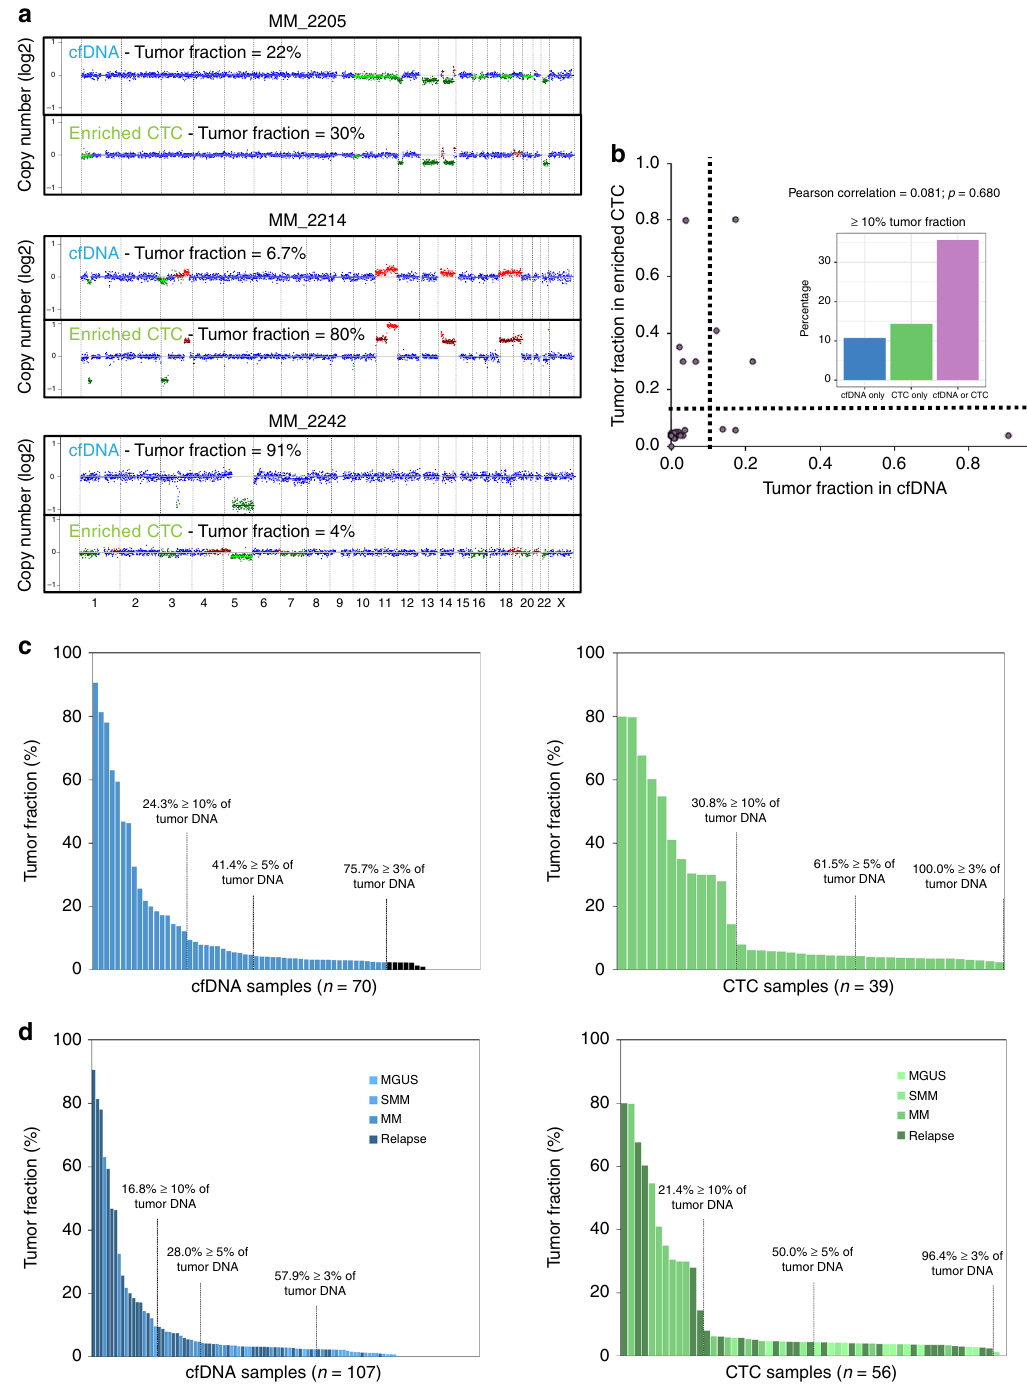
Fig. 1 Detectability of CTCs and cfDNA in multiple myeloma. a Comparison of copy ratios between cfDNA ULP-WGS and CTC ULP-WGS from same MM patients. Ampli fi cation (red), deletion (green), and copy neutral (blue) are indicated. b Comparison of tumor fraction of matched cfDNA and CTC samples as determined via ULP-WGS and ichorCNA. Dashed line indicates 10% tumor fraction. Percentage of patients with ≥ 10% tumor fraction for cfDNA only (blue), CTC only (green), and cfDNA or CTC (purple) is indicated. Pearson correlation coef fi cient was calculated between the tumor fraction in cfDNA and CTC (Pearson correlation = 0.081; p -value = 0.680). c ULP-WGS tumor fraction estimates for 70 cfDNA samples and 39 enriched CTC samples from newly diagnosed MM and relapse patients; 76%, 41%, and 24% of cfDNA samples had ≥ 0.03, 0.05, and 0.1 tumor fractions, respectively (blue); 100%, 62%, and 31% of CTC samples had ≥ 0.03, 0.05, and 0.1 tumor fractions, respectively (green). d ULP-WGS tumor fraction estimates for 107 cfDNA samples and 56 CTC samples from MGUS, SMM, MM, and relapse patients; 58%, 28%, and 17% of cfDNA samples had ≥ 0.03, 0.05, and 0.1 tumor fractions, respectively (blue); 96%, 50%, and 21% of CTC samples had ≥ 0.03, 0.05, and 0.1 tumor fractions, respectively